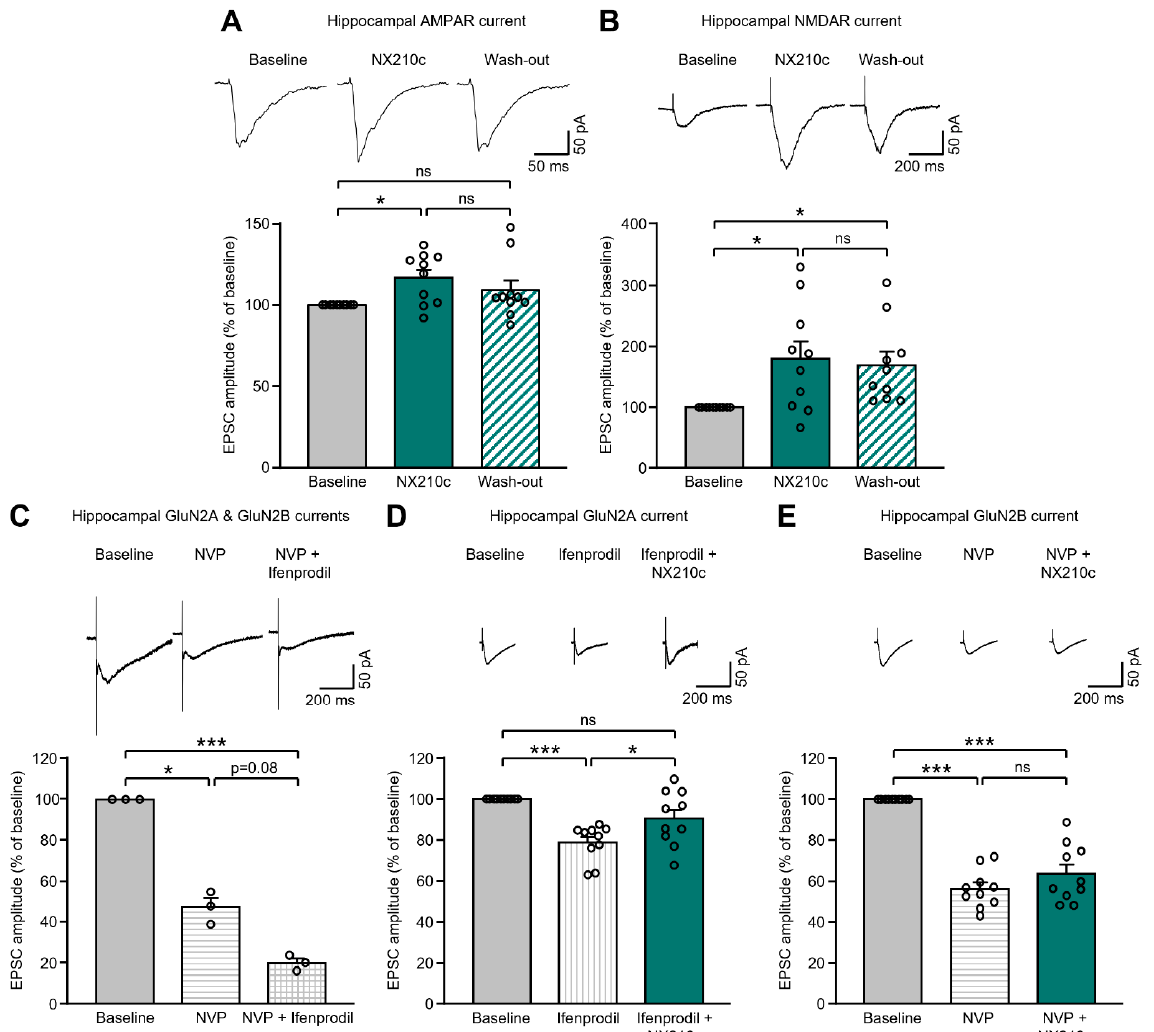
Figure 1. NX210c increased AMPAR- and NMDAR-mediated postsynaptic currents in the mouse hippocampus. ( A , B ) Top panels: representative traces of AMPAR-mediated excitatory postsynaptic currents (AMPAR-EPSCs) ( A ) and NMDAR-EPSCs ( B ) evoked in CA1 pyramidal neurons by Schaffer collateral stimulation in acute hippocampal slices before (baseline) and during superfusion with NX210c (250 µg/mL), and after a 10 min wash-out. Bottom panels: corresponding amplitudes of AMPAR- and NMDAR-EPSCs normalized to the baseline. ( C ) Top panel: representative traces of NMDAR-EPSCs in acute hippocampal slices exposed to NVP-AAM077 (GluN2A antagonist) and then Ifenprodil (GluN2B antagonist). Bottom panel: corresponding amplitudes of NMDAR-EPSCs normalized to the baseline. ( D , E ) Top panels: representative traces of NMDAR-EPSCs in acute hippocampal slices exposed to Ifenprodil (to isolate the GluN2A component of the NMDAR-EPSCs) and then NX210c ( D ) or exposed to NVP-AAM077 (to isolate the GluN2B component of the NMDAR-EPSCs) and then NX210c ( E ) Bottom panels: corresponding amplitudes of NMDAR-EPSCs normalized to the baseline. ( A – E ) Repeated-measures one-way ANOVA followed by Tukey’s multiple comparisons test: *** p < 0.001, * p < 0.05 compared with baseline; ns: not significant. n = 10 neurons from 10 slices extracted from 9 mice (i.e., 1 neuron per slice, 1–2 neurons per mouse) ( A , B ), n = 3 neurons from 3 slices extracted from 2 mice (i.e., 1 neuron per slice, 1–2 neurons per mouse) ( C ), and n = 10 neurons from 10 slices extracted from 5 mice (i.e., 1 neuron per slice, 2 neurons per mouse) ( D , E ). Individual data are indicated in white circles.